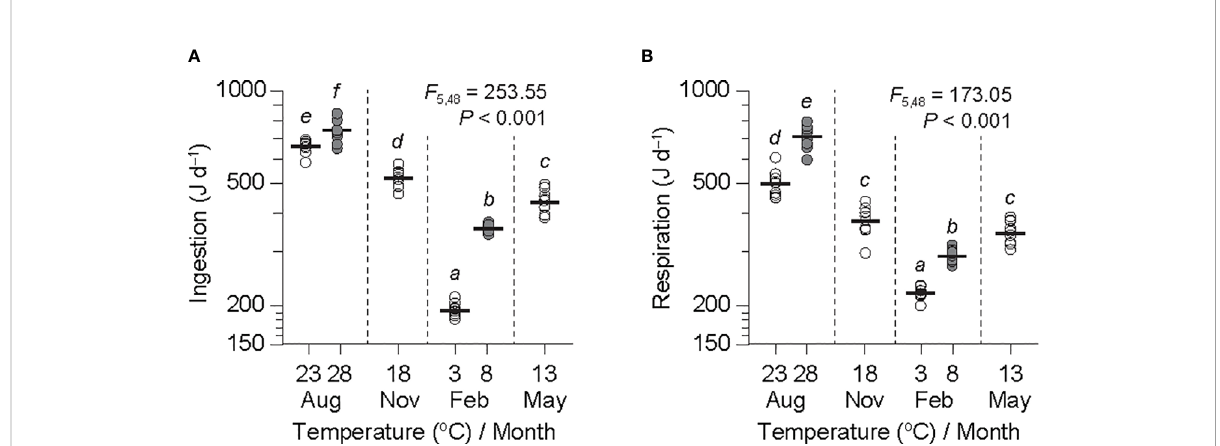
FIGURE 2 Rates of ingestion (A) and respiration (B) adjusted to an individual ark shell ( Anadara kagoshimensis ) with a dry- fl esh weight of 0.6 g recorded in August and November 2017, and February and May 2018, based on the common slopes ( (cid:1) b ) obtained at both temperature ranges from Table 2. Sample size, n = 9 in each group. The thick horizontal lines represent the means of individual groups. The open and closed circles of August and February represent cold and warm conditions in summer and winter, respectively. The results of an analysis of variance and subsequent Bonferroni post hoc test on the adjusted values are embedded in the fi gures. The same letters indicate the absence of signi fi cant differences between means.